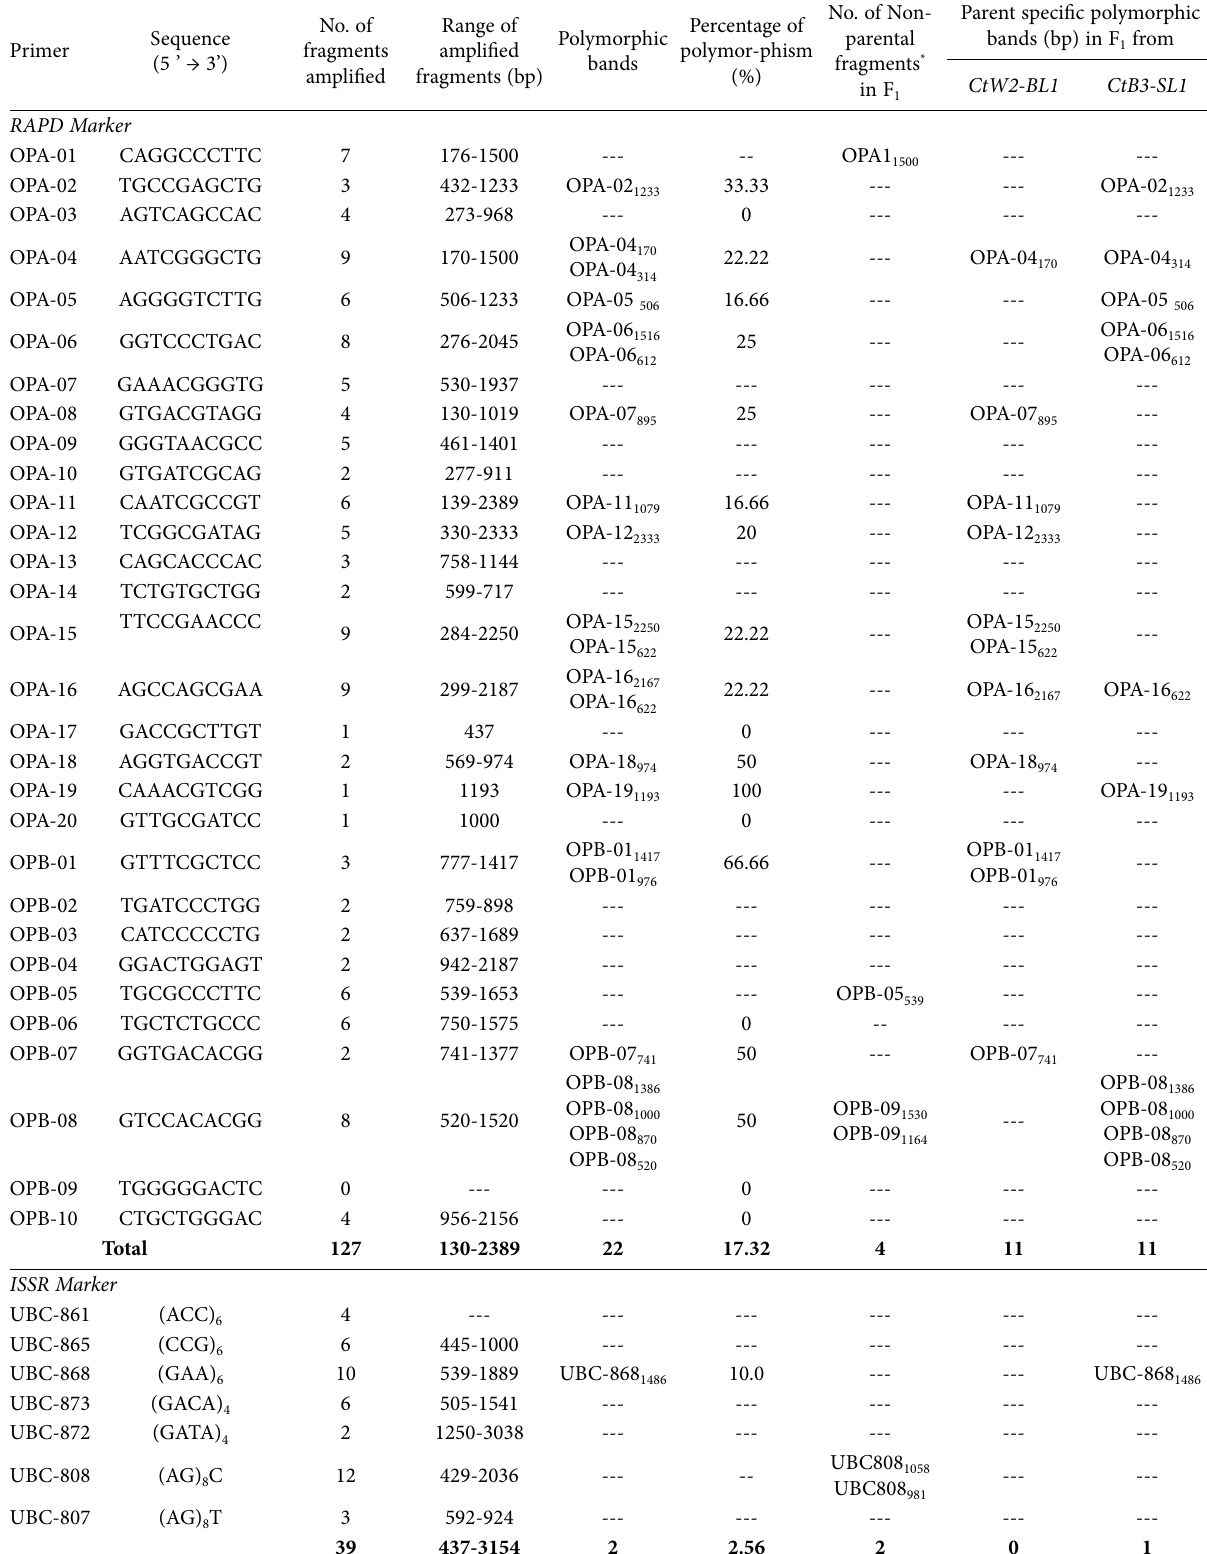
Table 4. Details of RAPD and ISSR markers used for characterization of intraspecific F 1 hybrid showing the inheritance of parent specific markers to the intraspecific F 1